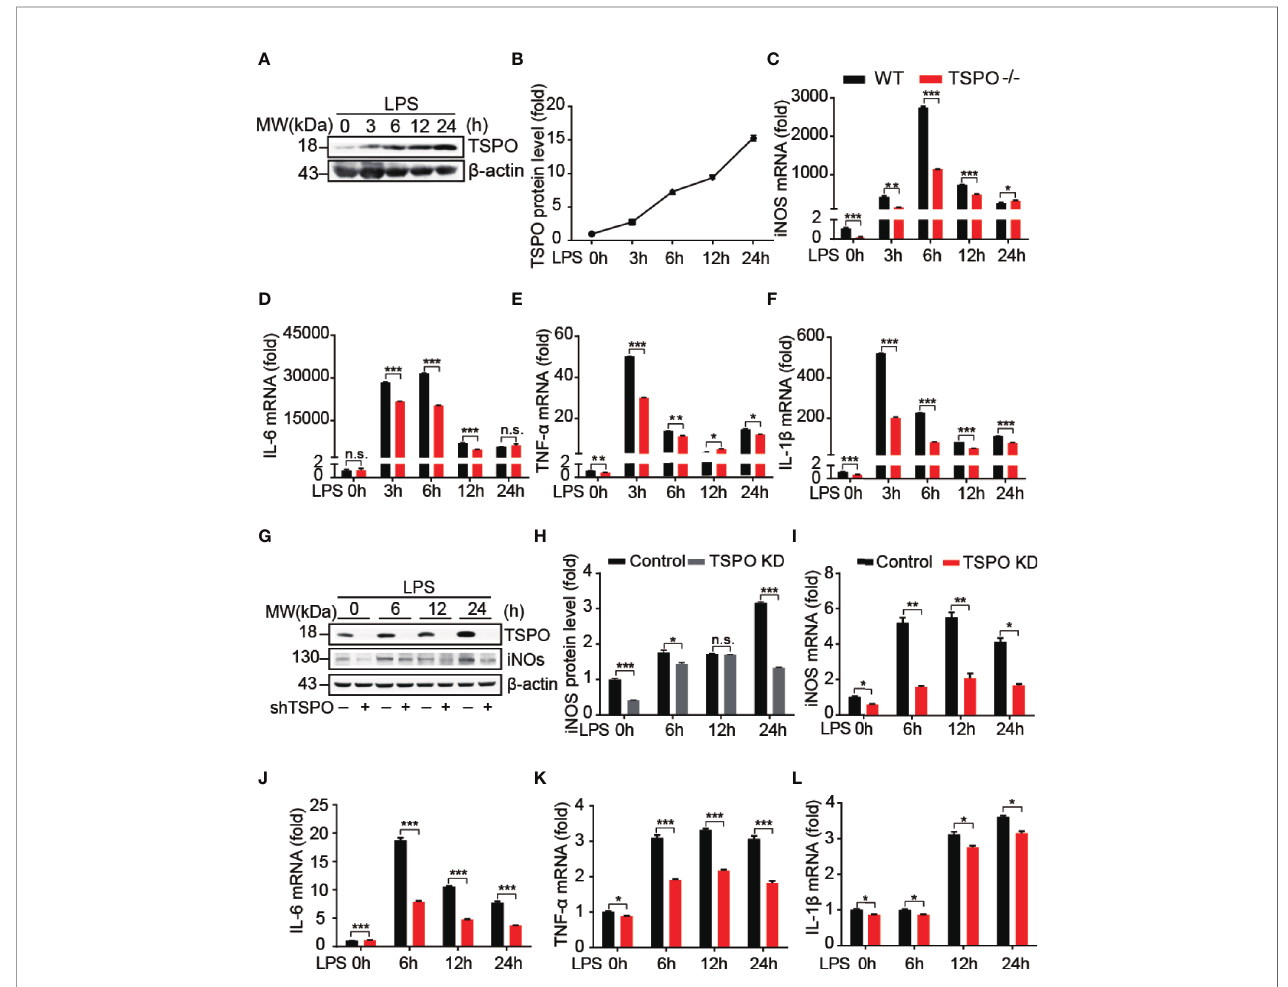
FIGURE 1 | TSPO de fi ciency inhibits LPS-induced in fl ammation in microglia. WT and TSPO − / − primary microglial cells were stimulated with LPS (1 µg/ml) for the indicated amounts of time. (A, B) Western blot analysis of TSPO protein changes after LPS stimulation. (C – F) RT-qPCR determined mRNA changes in the proin fl ammatory genes iNOS, IL-6, TNF- a , and IL-1 b . The same conditions were applied to shvector and shTSPO BV2 cells. (G, H) Western blot analysis of TSPO and iNOS levels in control and TSPO-knockdown BV2 cells. (I – L) RT-qPCR analysis of changes in the mRNA levels of the proin fl ammatory genes iNOS, IL-6, TNF- a , and IL-1 b . Data are expressed as the mean ± SEM. Data were analyzed using one-way ANOVA. *p < 0.05, **p < 0.01, ***p <